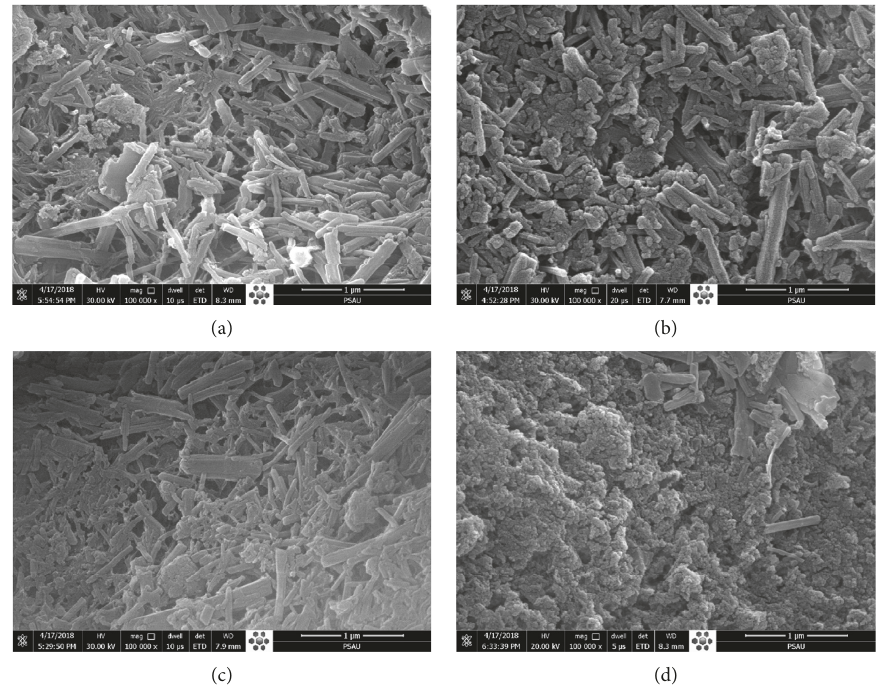
Figure 10: SEM micrographs for cement-marble powder paste: (a) CMP1, (b) CMP2, (c) CMP3, and (d)